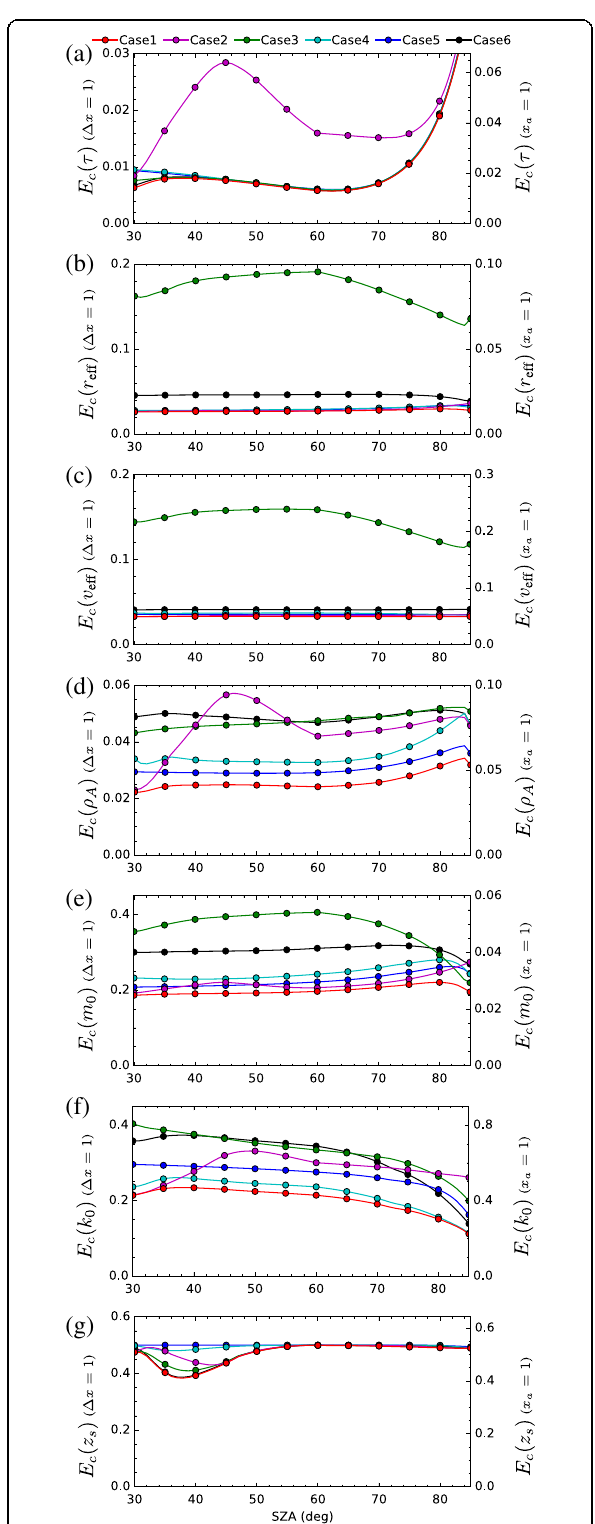
Fig. 8 Combined propagation errors of dust model parameters. The definitions of cases 1 – 6 are the same as in Fig. 7. The left and right scales are normalized so that Δ x =1 and x a =1, respectively, and panels ( a ) - ( g ) show the relation between propagation error and SZA for X 1 - X 7 ,